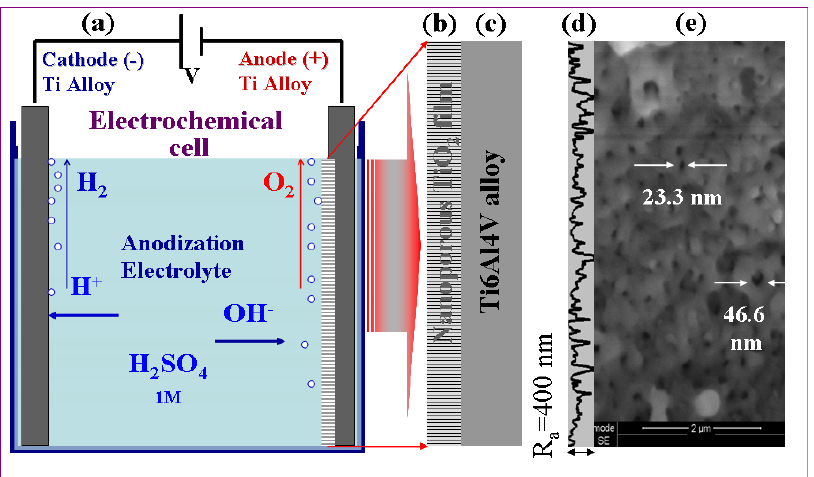
Figure 1. Presentation of the electrochemical oxidation process to obtain the nanoporous TiO 2 film on grade 5 Ti6Al4V alloy: ( a ) electrochemical cell showing the electrodes and reactions at the electrodes in the anodizing electrolyte; ( b ) a schematic of nanoporous TiO 2 on a titanium alloy surface; ( c ) the Ti6Al4V bulk alloy; ( d ) the measured roughness of TiO 2 nanoporous film approximated as nanopore depth; and ( e ) SEM surface morphology of TiO 2 nanoporous film showing the measurements of nanopore diameters.